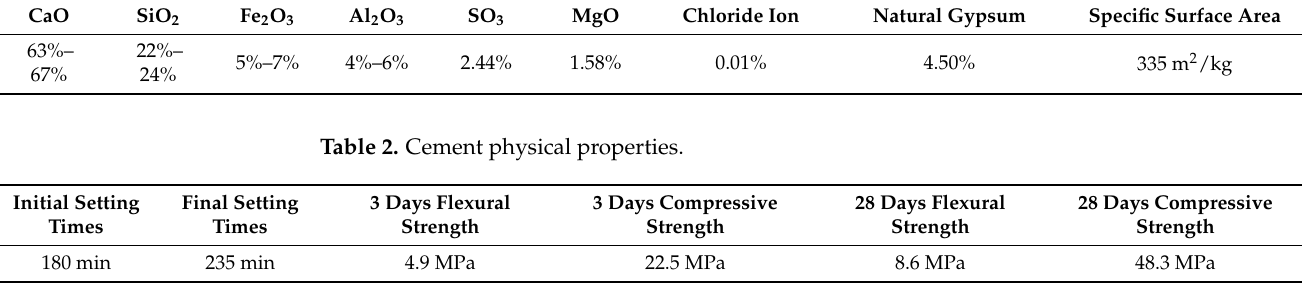
Table 1. Components and specific surface area of cement.